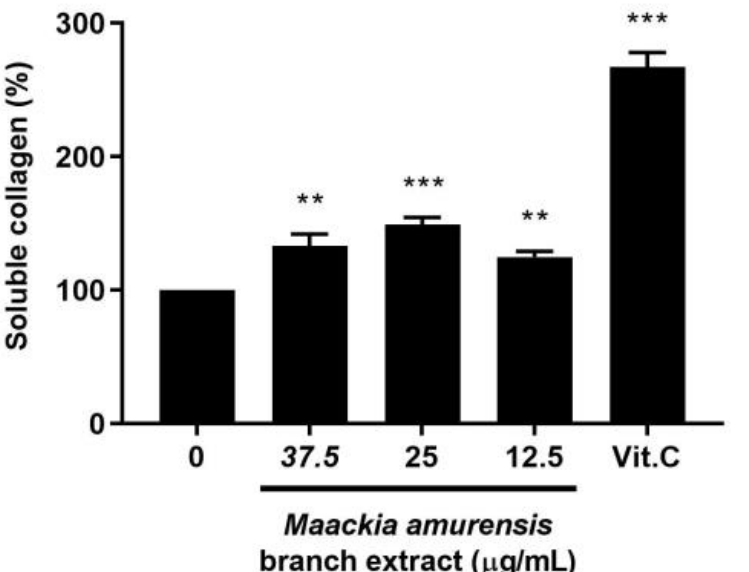
Figure 5. Effect of Maackia amurensis branch extract on soluble collagen in CCD-986sk cells. CCD-986sk cells were treated with ascorbic acid (100 µ g/mL) or various concentrations (37.5, 25, and 12.5 µ g/mL) of M. amurensis branch extract for 24 h. M. amurensis branch extract significantly increased the level of soluble collagen. Data are presented as mean ± SD of three independent experiments. p -value between control and M. amurensis branch extract groups (** p < 0.01 and *** p <